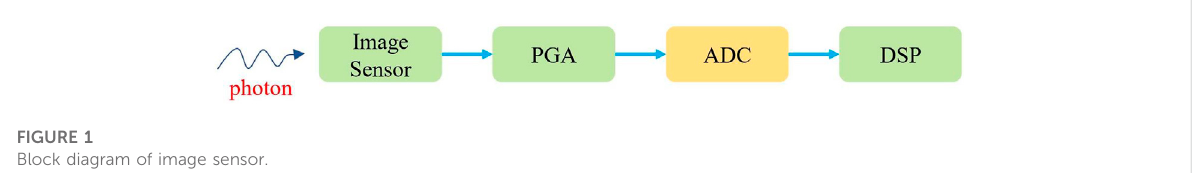
FIGURE 1 Block diagram of image sensor.